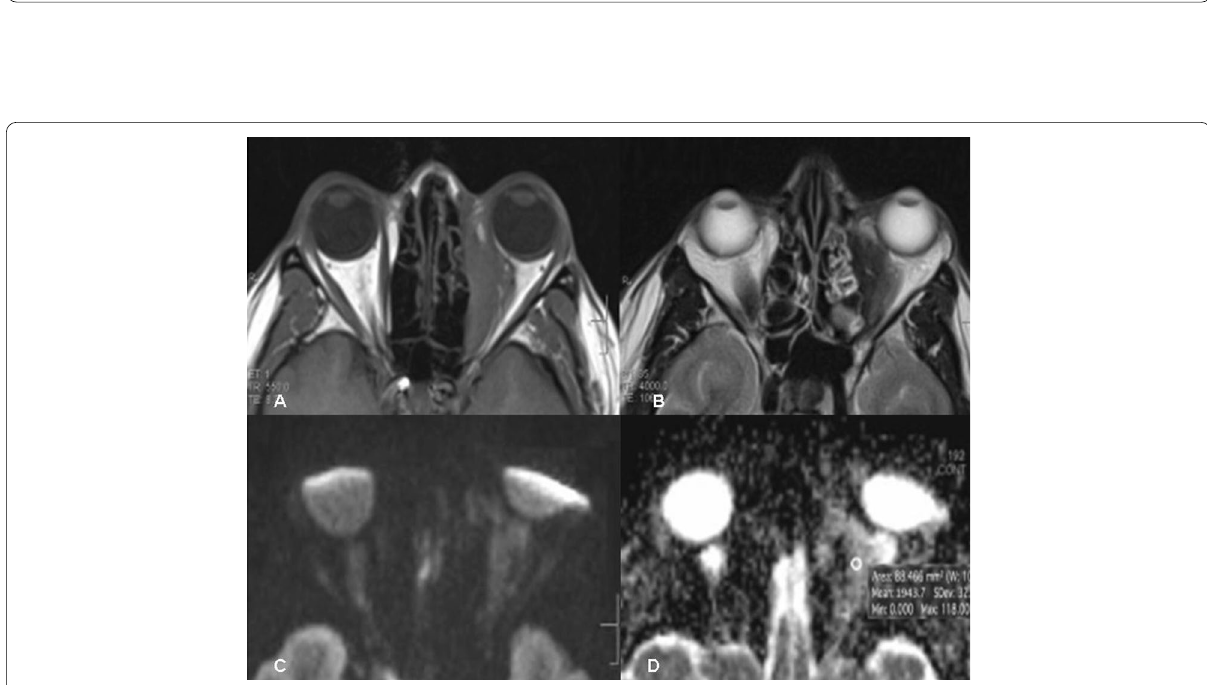
Fig. 3 A 13-year-old male with acute pan-sinusitis; presented with right-sided dull aching orbital pain, mild proptosis and limited orbital gaze. Axial T1 image ( A ) shows diffusely enlarged right superior and medial recti with mild haziness of the right intraconal retro bulbar fat. Axial T2 image ( B ) shows diffuse enlargement of the right superior and medial recti muscles with mild hyperintense signal. No diffusion weighted restriction seen on DWI (b 500 ) image ( C ) and ADC ( D ). The ADC value is 1.34 10 − 3 mm 2 /sec. Right-sided orbital inflammatory pseudotumor, Myositic type. Therapeutic × trial with corticosteroids was done and the patient relieved after 5